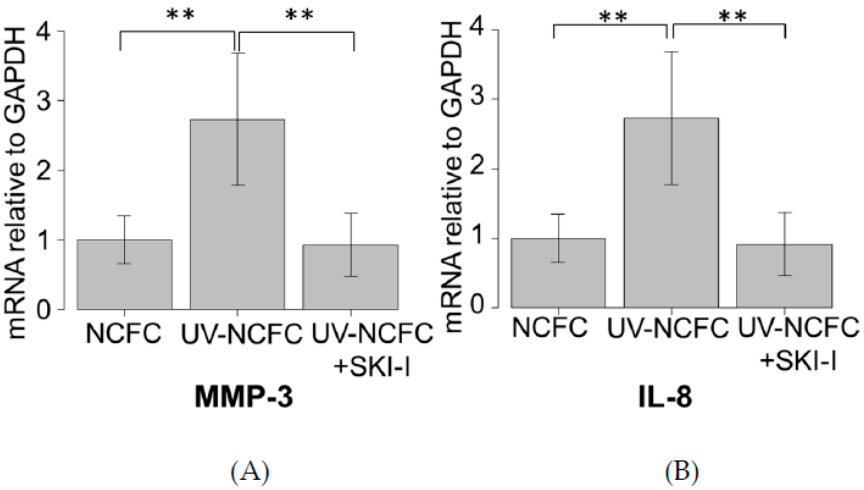
Figure 9. qPCR quantification of NCFCs UV-NCFCs with or without SKI-I. mRNA expressions of MMP-3 and IL-8 relative to GAPDH ( n = 4). The relative mRNA expression of MMP-3 and IL-8 was significantly higher in UV-NCFCs than in NCFCs. ** p < 0.01.